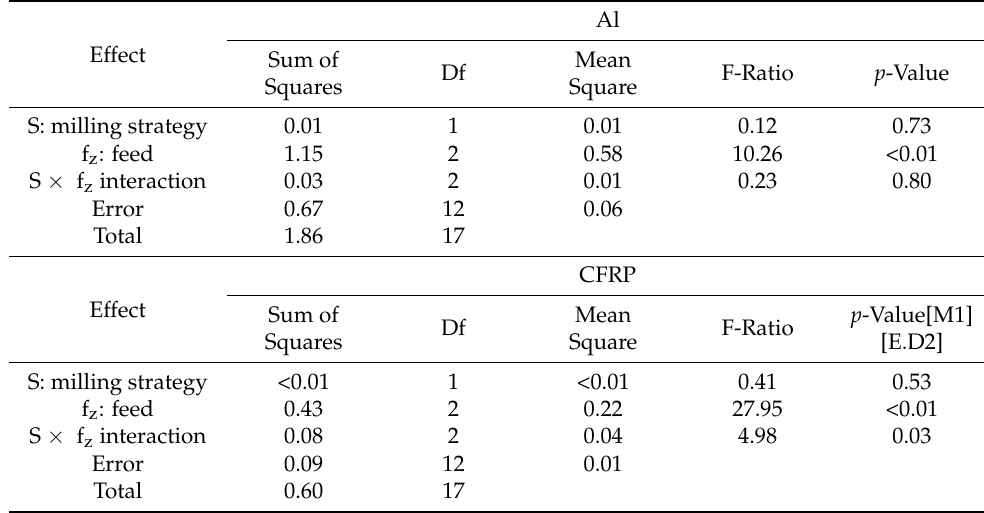
Table 1. ANOVA variance analysis results for the Ra surface roughness parameter.